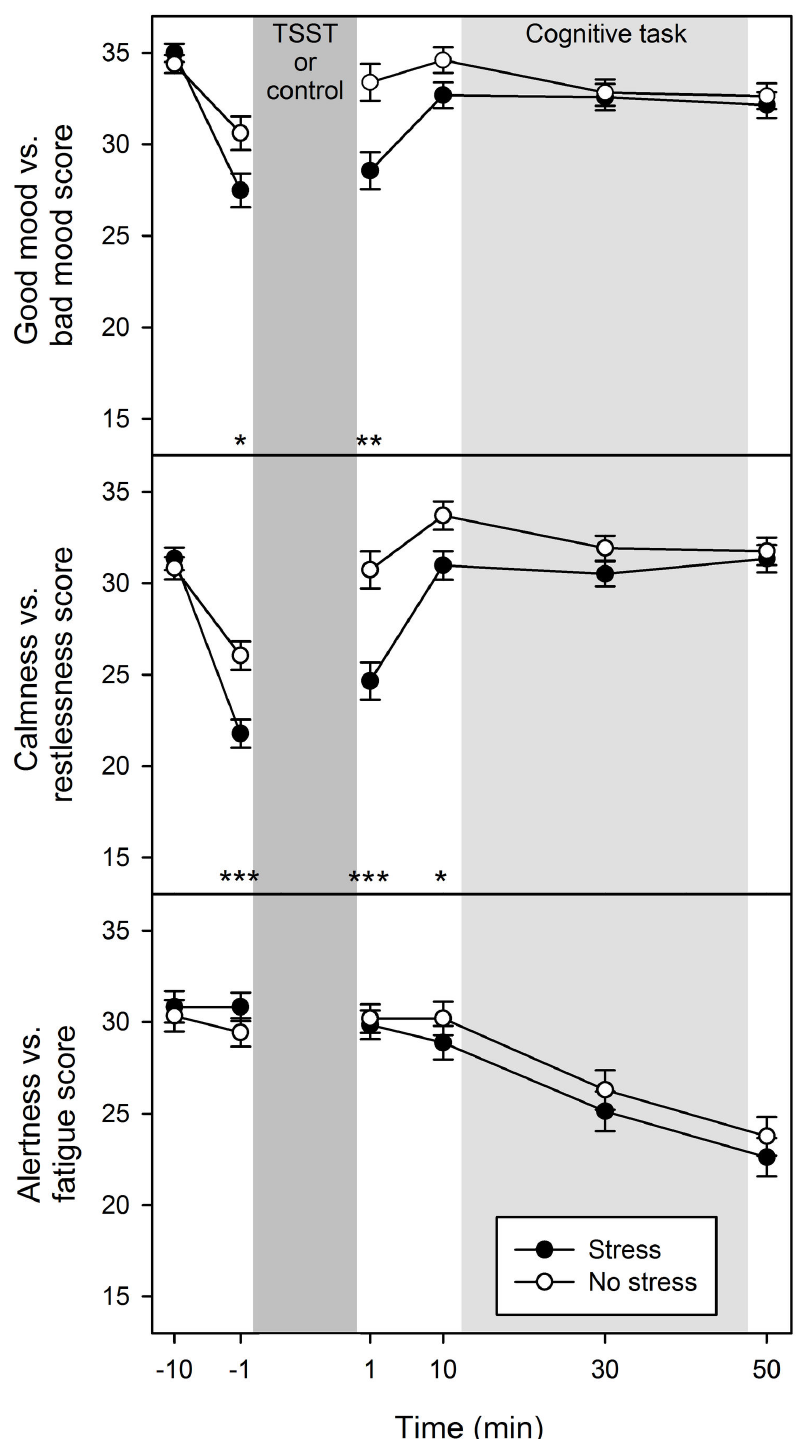
Figure 3. Mental state. Mean mental state scores on the three subscales good mood vs. bad mood, calmness vs. restlessness, alertness vs. fatigue from the German “Mehrdimensionaler Befindlichkeitsfragebogen” (multidimensional mental-state questionnaire, MDBF [31]) for the stress group and the no-stress group over the time-course of the experimental session (minutes before or after the Trier Social Stress Test [TSST] or the control condition, respectively). Error bars represent standard errors. * p < .05, ** p < .01, *** p < .001. doi: 10.1371/journal.pone.0085685.g003 PLOS ONE |